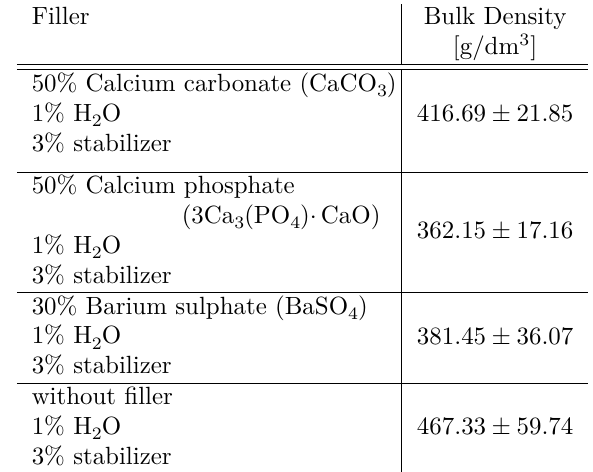
Table 1. Average bulk density of the samples